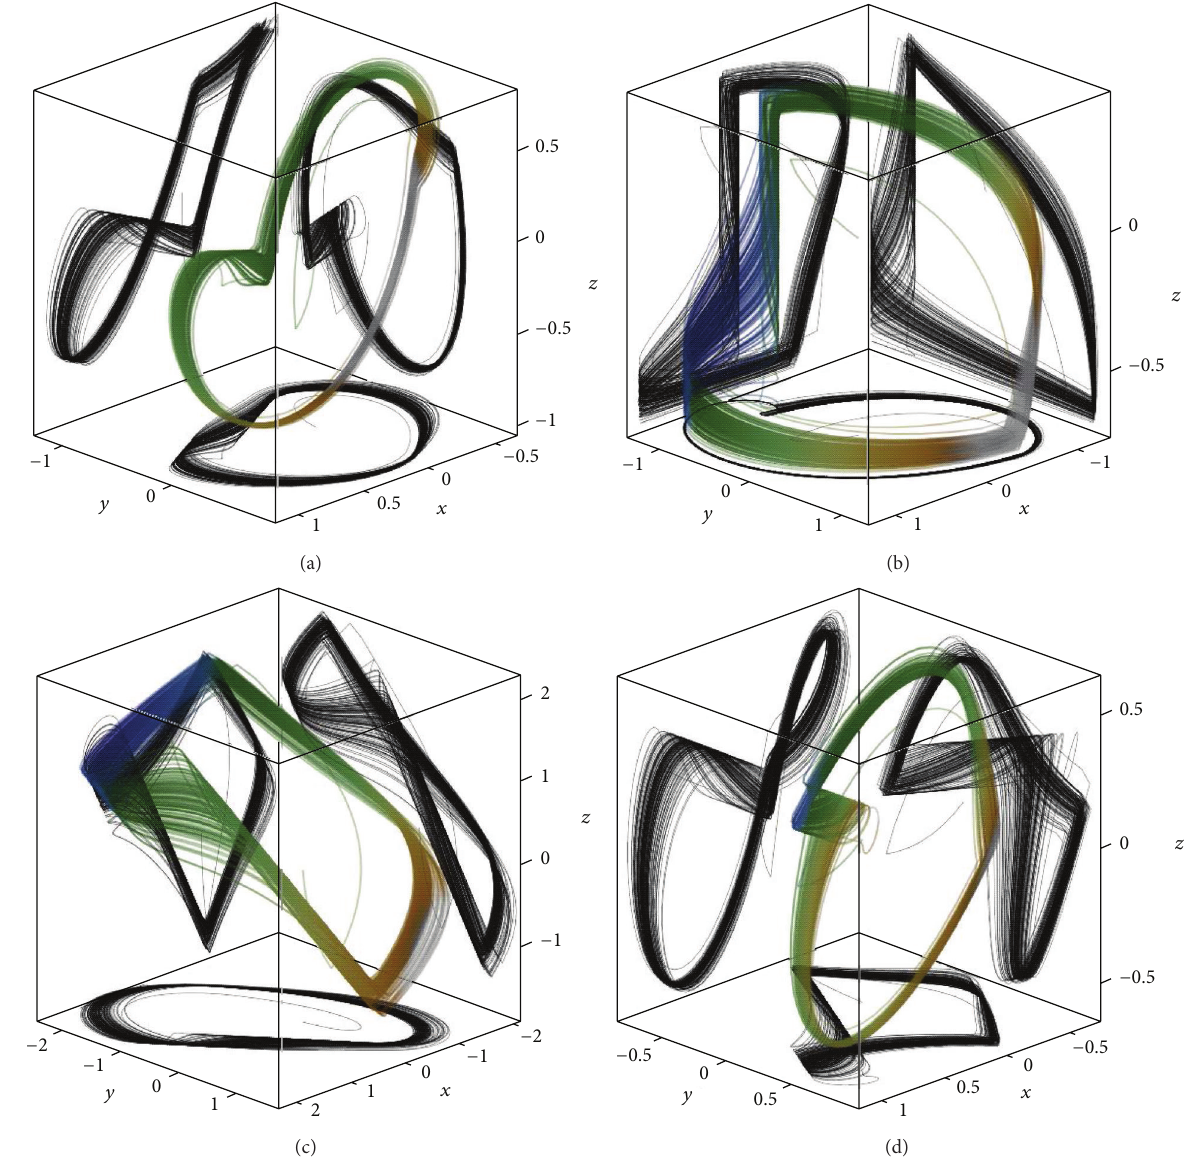
Figure 2: System configuration 𝐵 in normal form (a), Jordan form (b), and first and second equivalent.